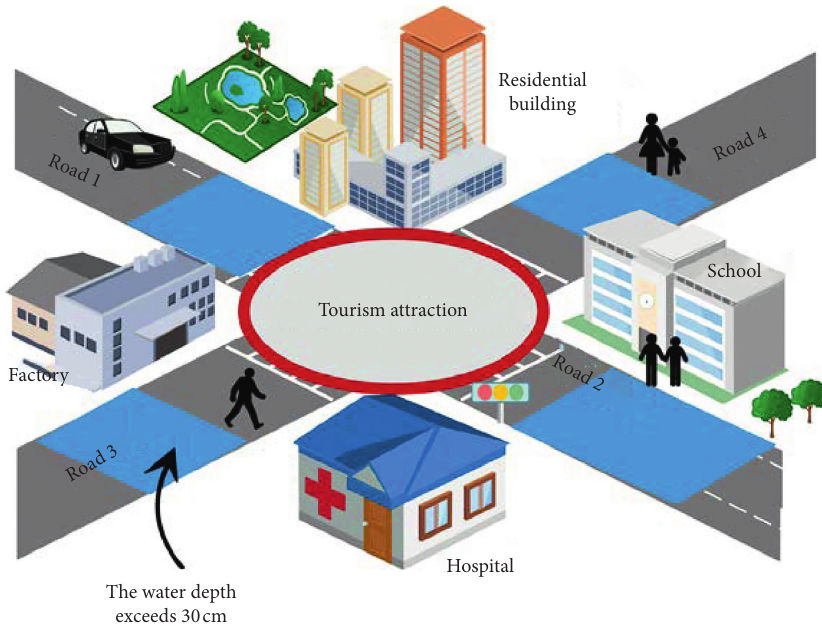
Figure 2: Tourism attraction in the emergency blind Table 1: Maximum speed limit in different classes of roads and speeds in different conditions. Type